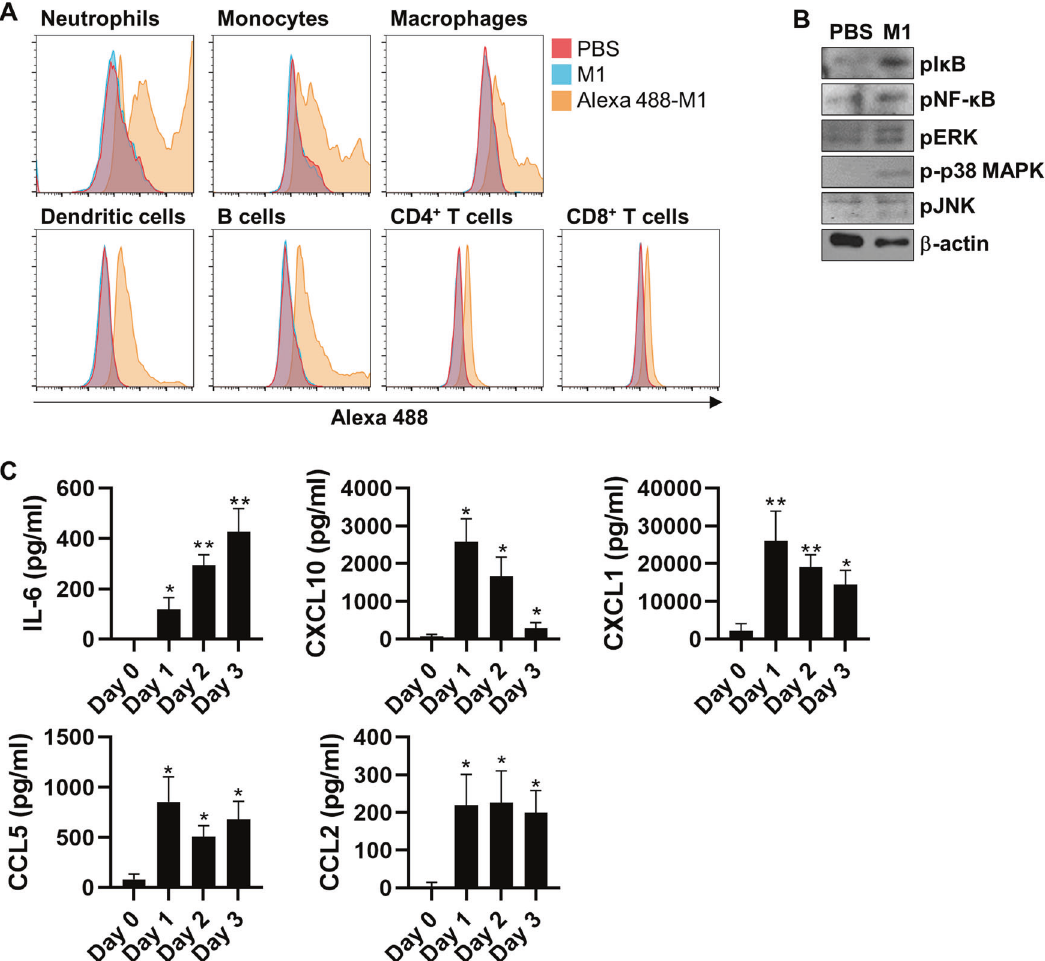
Fig. 4 M1 recognizes pulmonary immune cells and activates in fl ammatory responses in mouse lungs. A Cells isolated from mouse lungs were treated with rM1 or Alexa 488-labeled rM1 (15 μ g/ml) for 15 min and then analyzed by fl ow cytometry to determine the M1 – cell association ( n = 5 ). B Mice were intranasally treated with PBS or rM1 (15 μ g/ml) for 6 h ( n = 5 ). BAL fl uid cells were isolated from these mice and subjected to immunoblotting to detect the activation of NF- κ B and MAPK signaling. C Mice were intranasally treated with PBS or rM1 (30 μ g/ ml) for 0 – 3 days. BAL fl uid was extracted from these mice and subjected to ELISA every day to measure the levels of the indicated cytokines and chemokines ( n = 5 ). Data are presented as mean ± standard error of the mean (SEM). ** p < 0.01, * p <